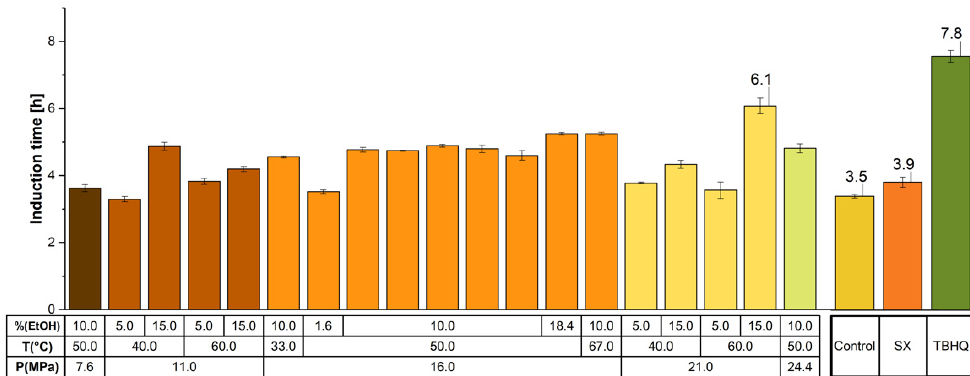
Figure 2. Oxidative stability of SEO as measured by the induction time (h) using the Rancimat method. SEO was added with SFE and Soxhlet extracts, and TBHQ as synthetic antioxidant, an SEO without antioxidants was included (Control).